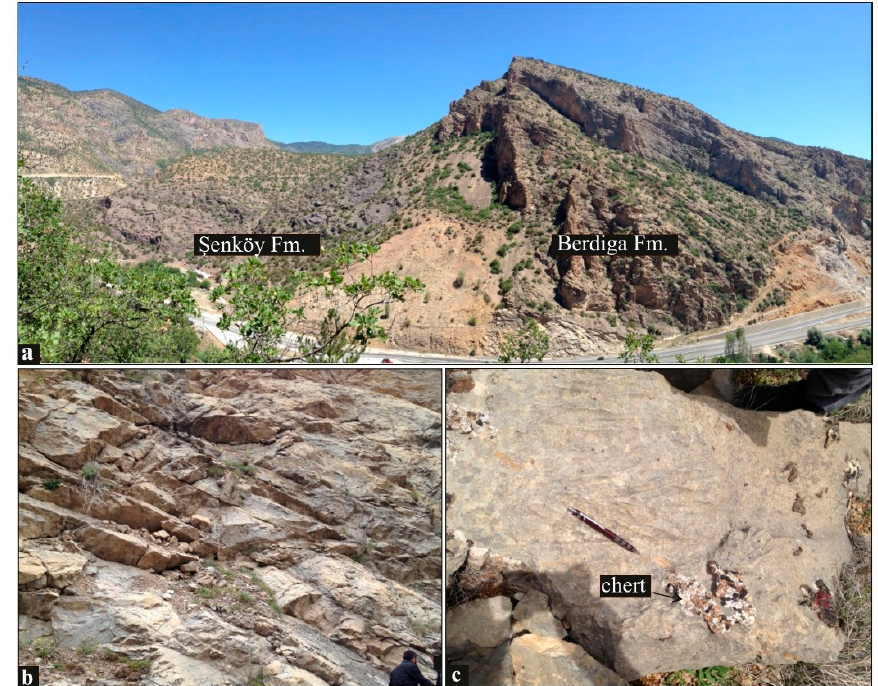
Figure 3. General lithological and macro-micro sedimentological features of the inner platform to slope environment in the interval of the Berdiga Formation (Hauterivian-Albian). ( a ). Field view of the Mescitli stratigraphic section; ( b ) thick to medium bedded Limestone (MF-1); ( c ) limestone with chert (MF-2 and MF-3).